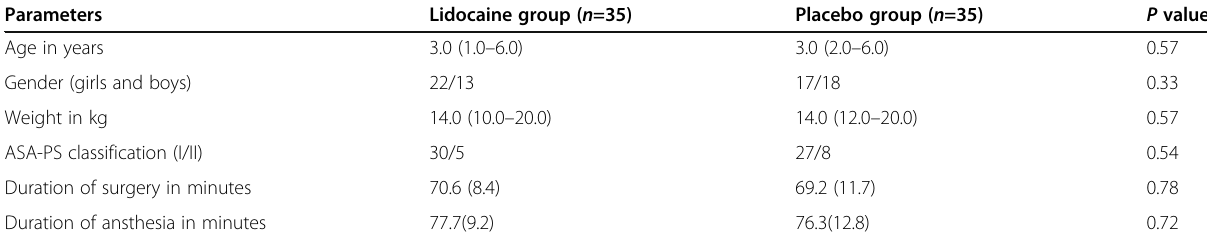
Table 1 Comparison of demographic data in the two groups Parameters